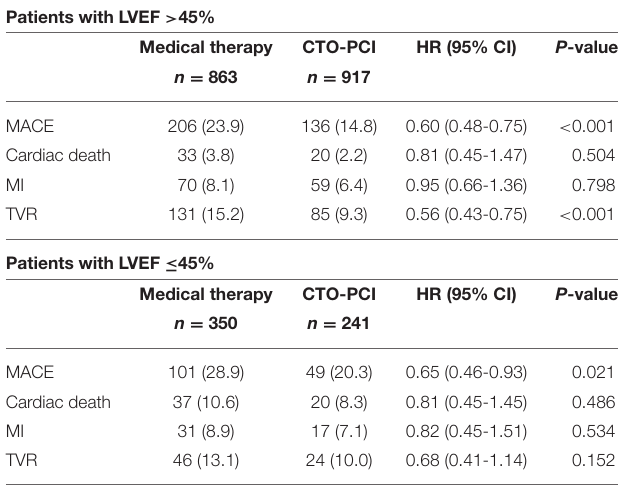
TABLE 6 | Clinical outcomes of patients with different LVEF stratified according to management. Patients with LVEF < 40%